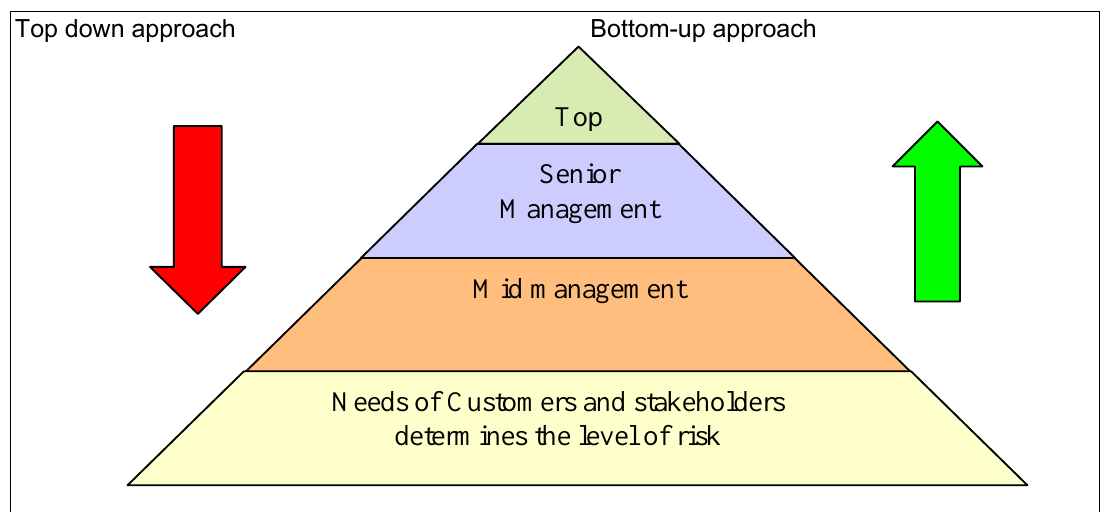
Figure 1: Top-down and bottom-up approach Top down approach Bottom-up approach